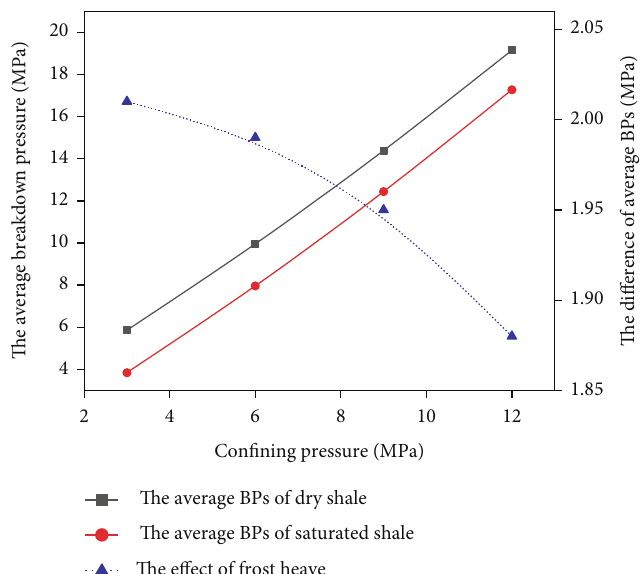
preconditioning under 2